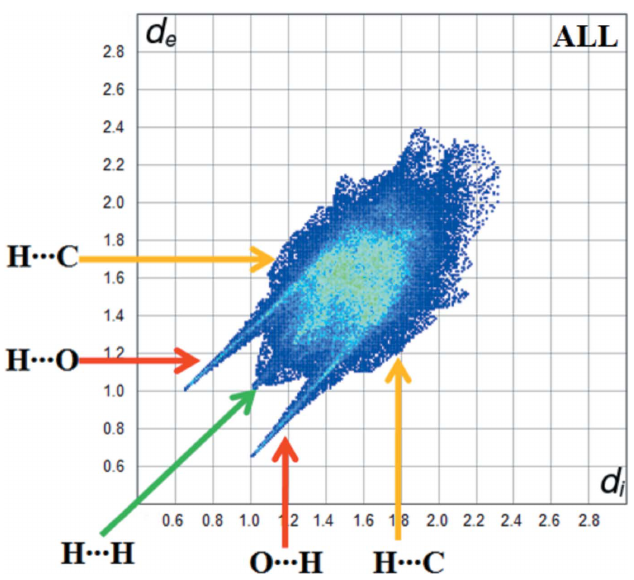
Figure 5 The fingerprint plot for all